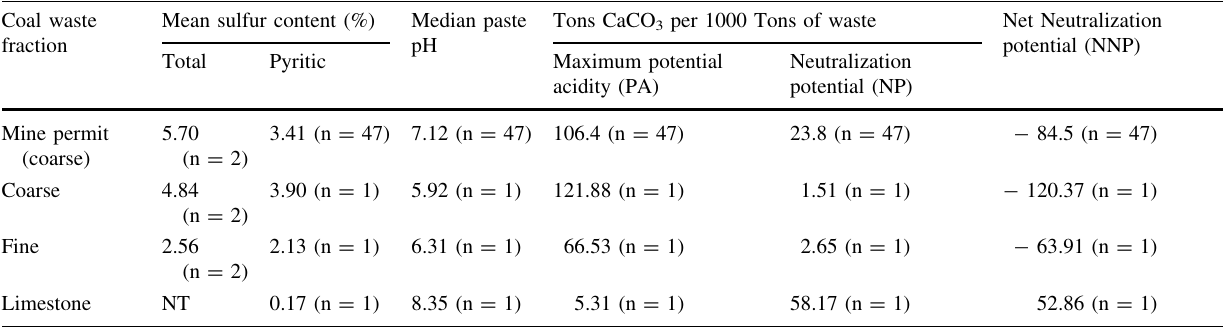
Table 2 Geochemical properties of coal waste and ground limestone samples Coal waste